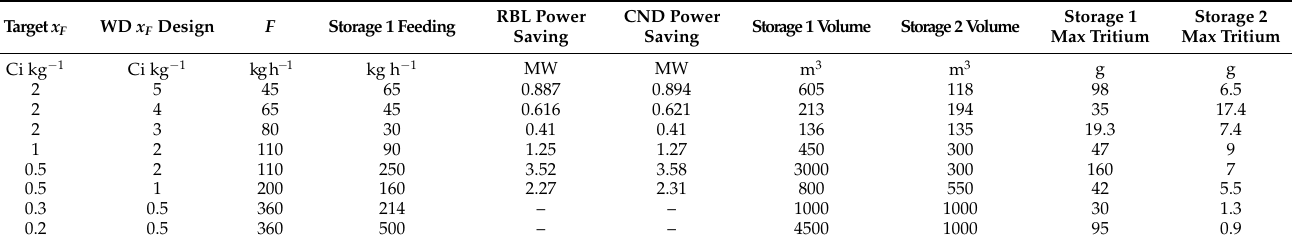
Table 3. Sizing and operation of full hybrid strategy for the water